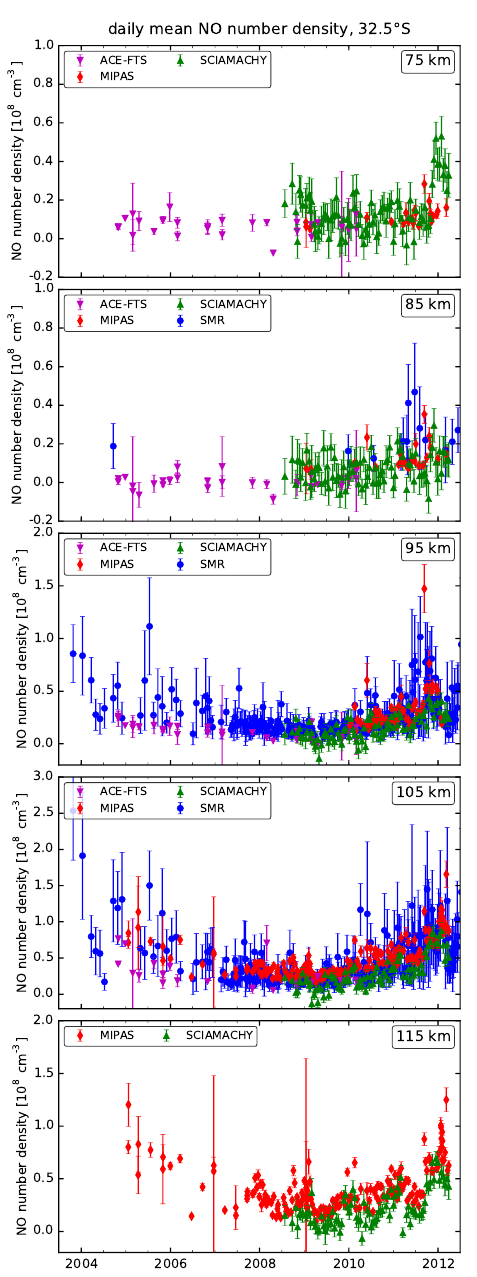
Figure B4. NO time series comparison of all four instruments at 2.5 ◦ N, for 75km, 85km, 95km, 105km, and 115km (from top to